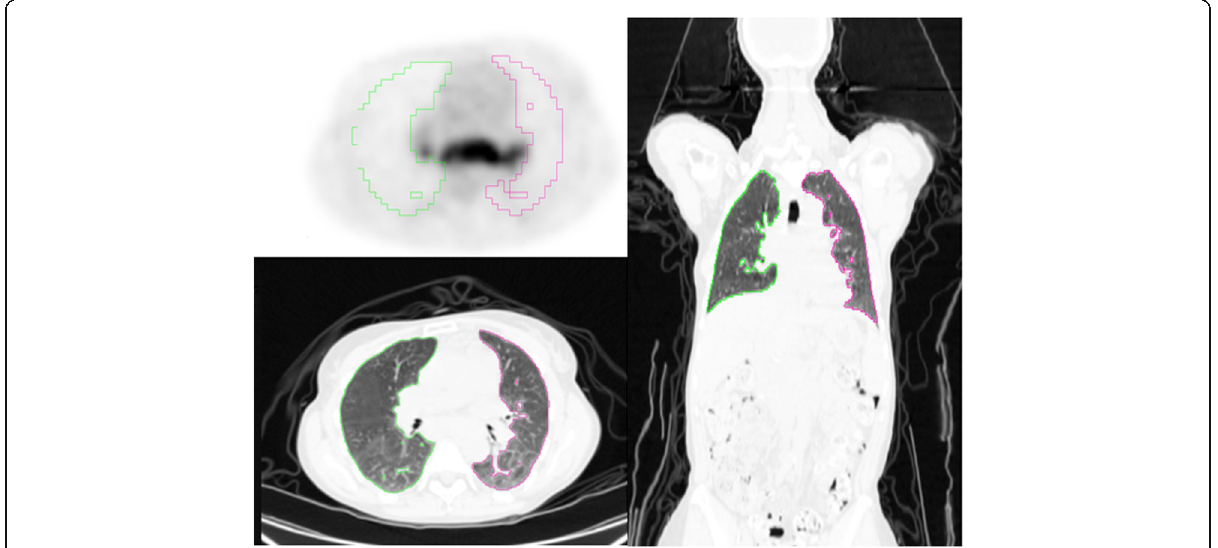
Fig. 1 Example of VOI of total lung glycolysis. TLuG is the cumulative metabolic activity in the total lung parenchyma. Additionally, SUVmax and SUVmean are determined in the